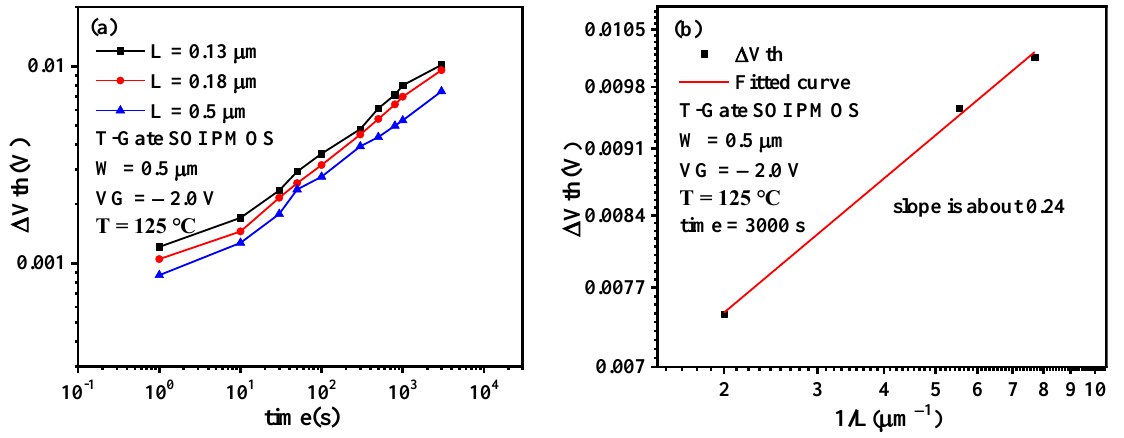
Figure 11. ( a ) Time evolution of ∆ V th degradation under different channel lengths. ( b ) ∆ V th degrada- tion dependence on the channel length.